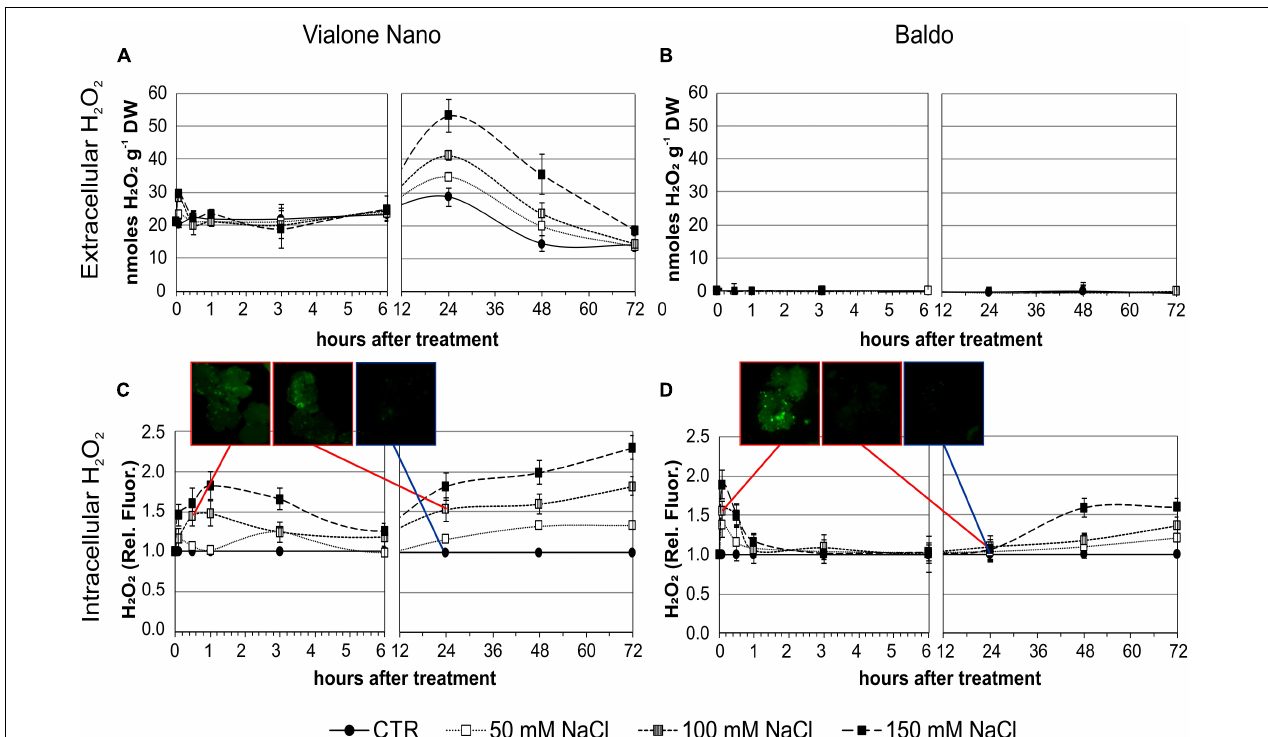
FIGURE 4 | H 2 O 2 produced by rice suspension cell cultures of VN and B and measured at different time points after salt treatment. Closed circles – straight line, Control; open squares – dotted line, 50 mM NaCl; gray squares – small-dashed line, 100 mM NaCl; closed squares – dashed line, 150 mM NaCl. (A,B) H 2 O 2 released in the medium; DW, Dry weight. (C,D) Intracellular H 2 O 2 measured using the DHR-123 method; values were normalized against the levels of control cells, which were given a value of 1 and therefore have no SD. Insets are representative images of stained cells at different timepoints. Values represent the mean ± SE of three independent